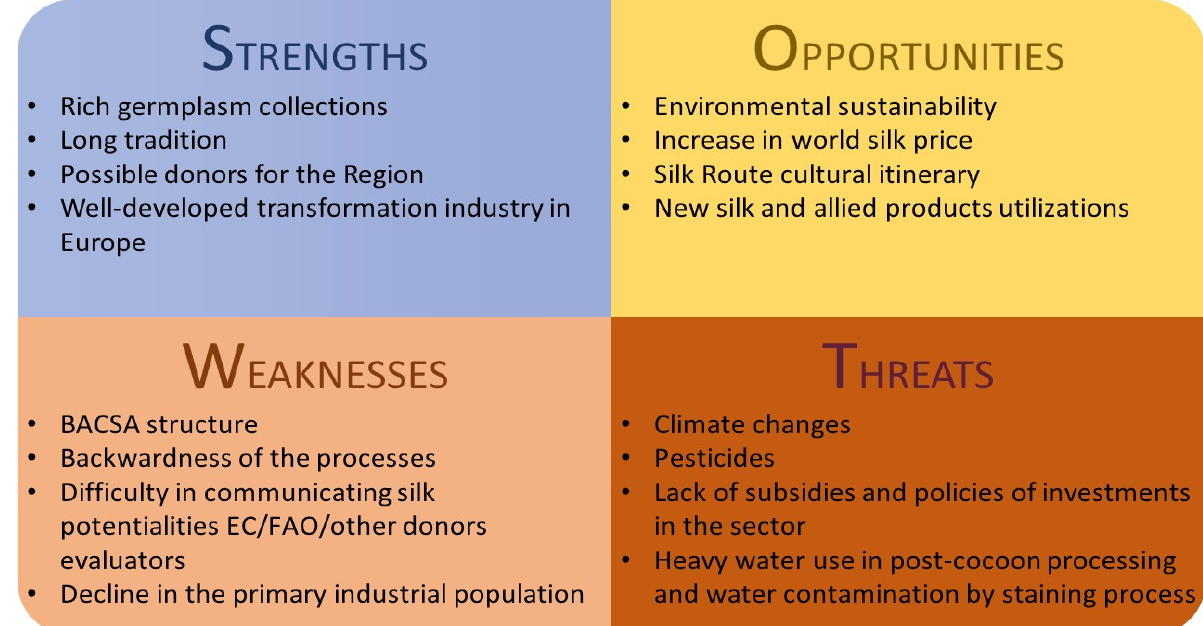
Figure 1. SWOT analysis representing criticalities and qualities of BACSA examined with respect to the possibilities of success in revitalizing the sericultural activity in the area.